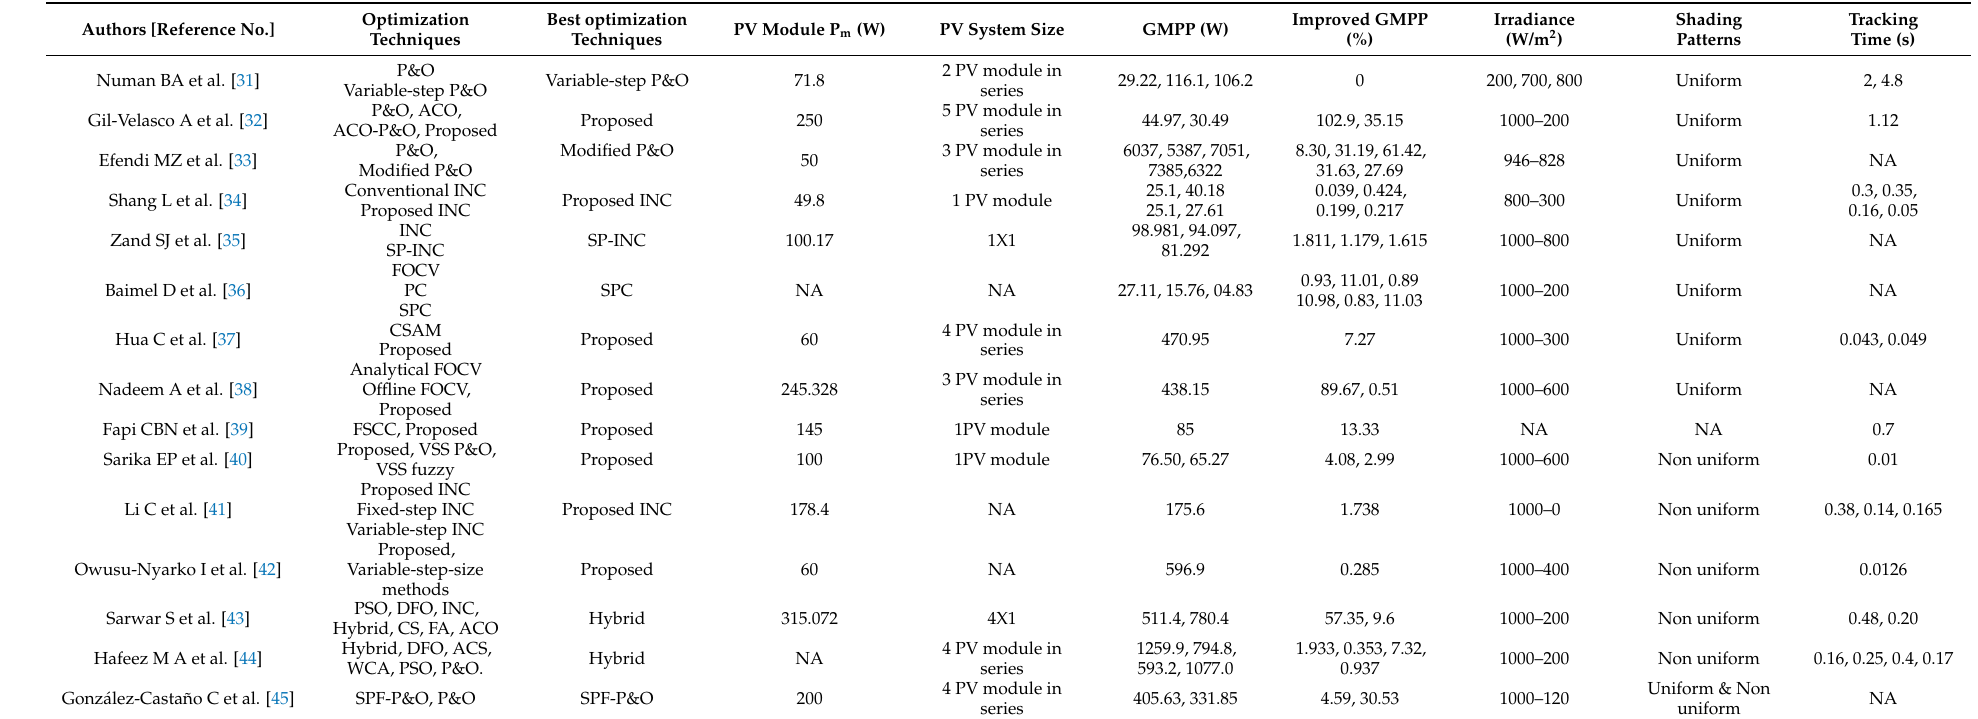
Table 1. Taxonomy on recent reported work on conventional techniques to track